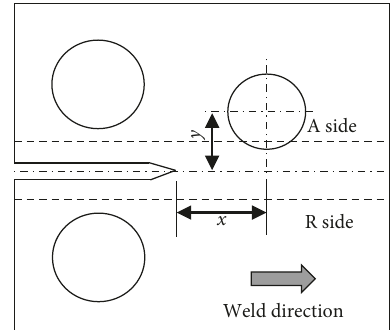
Figure 15: Hole position.